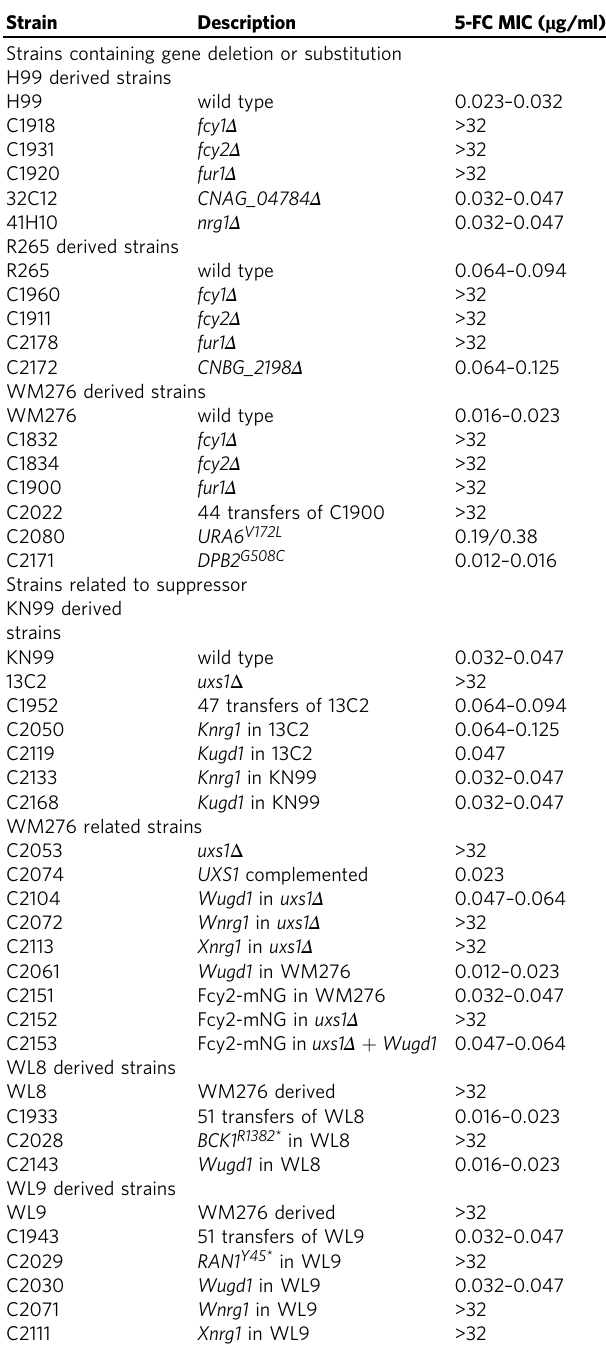
Table 2 MIC determined by Lio fi lchem ® MIC Test Strips TM .